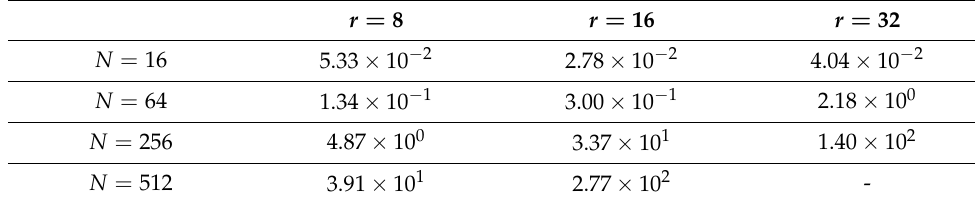
Table 3. The times in second cost by Algorithm 1.